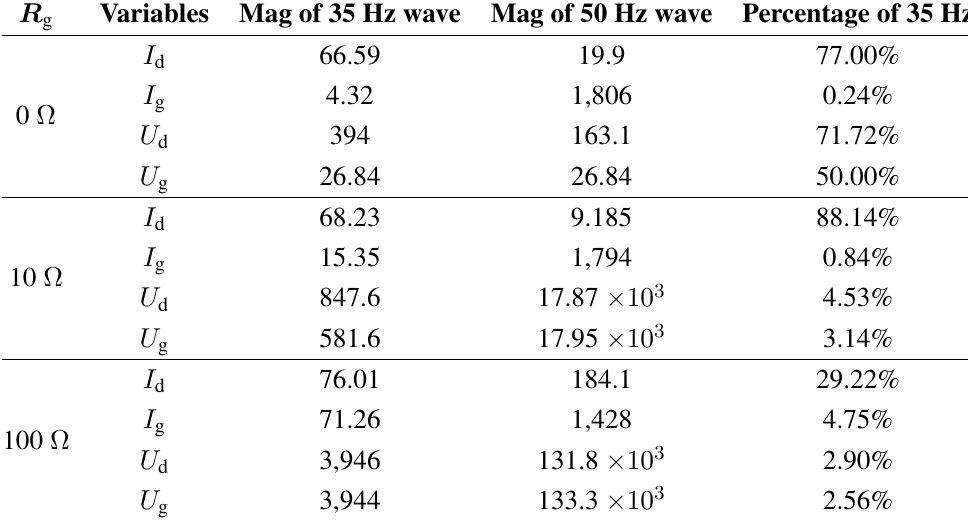
Table 3. Fast Fourier transformation analysis of currents and voltages with 69 wind turbines.